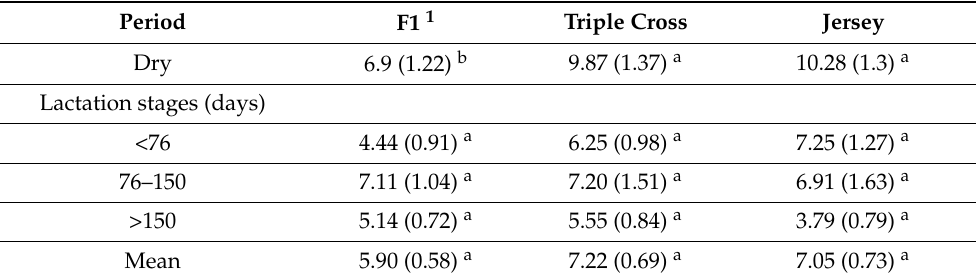
Table 6. Enteric CH 4 conversion factor (Y m —%) in dry and lactating cows according to breed group (mean +